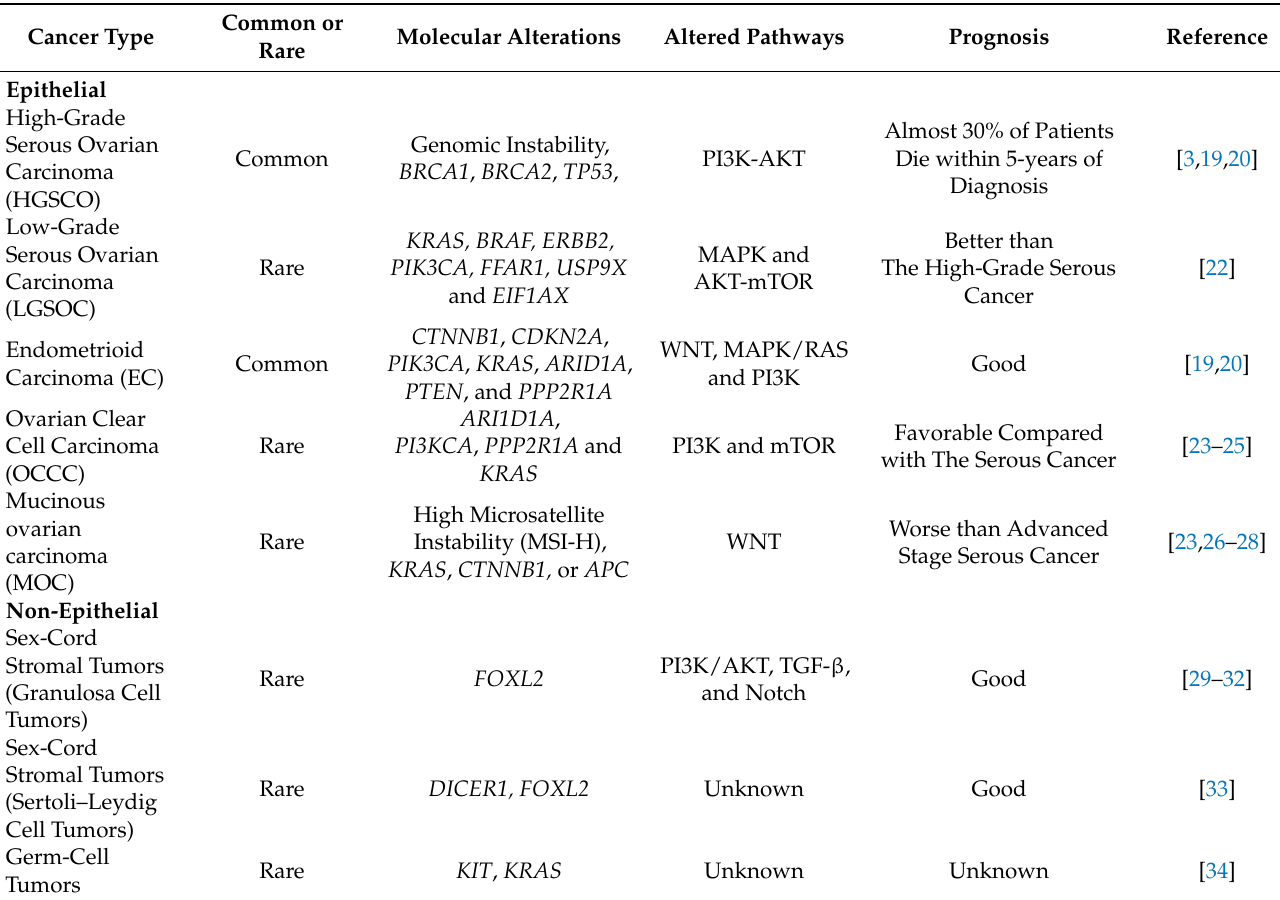
Table 1. Molecular alterations and prognosis of different types of ovarian